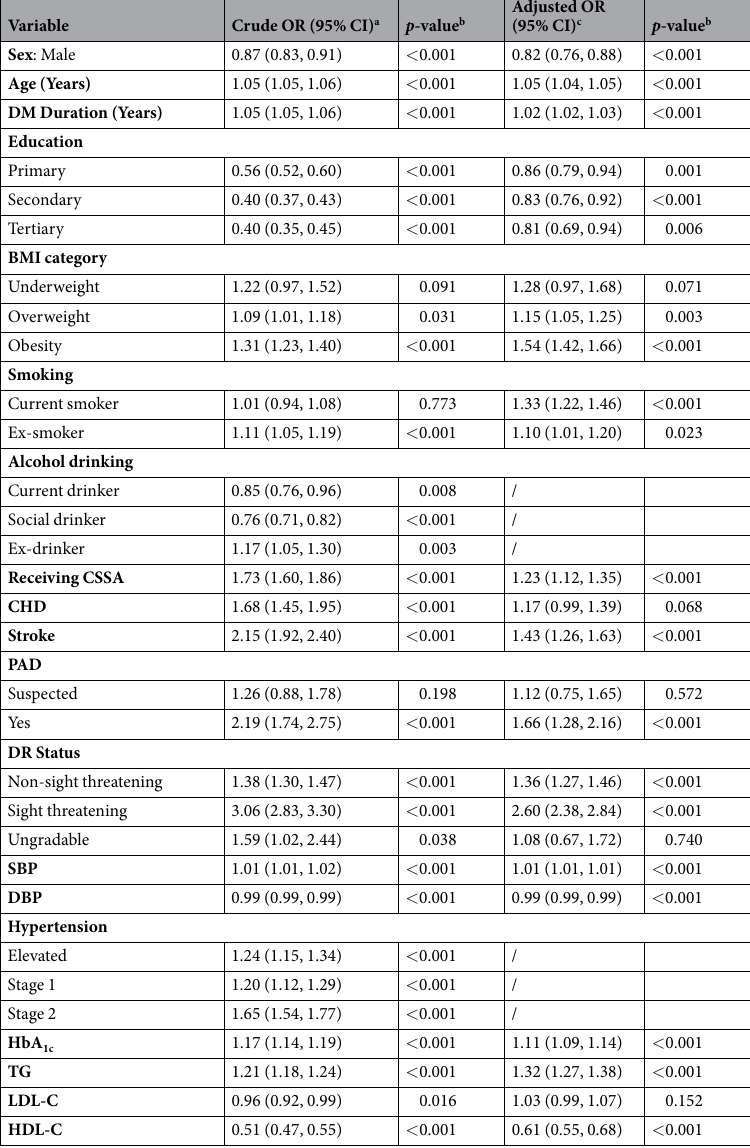
Table 2. Crude and adjusted odds ratio (OR) of chronic kidney disease (CKD) associated with different factors. Reference level for sex = female, education = no formal education, BMI category = normal, smoking = non- smoker, alcohol drinking = non-drinker, receiving CSSA = no, hypertension = normal, CHD = no, stroke = no, PAD = no, DR status = no. a Crude OR estimated from the univariate logistic regression models. b p-value of Wald test for individual factors. c Adjusted OR estimated from the stepwise multivariate logistic regression model with all the above variables added except hypertension stages. The variable of alcohol drinking was eliminated from the final model during stepwise